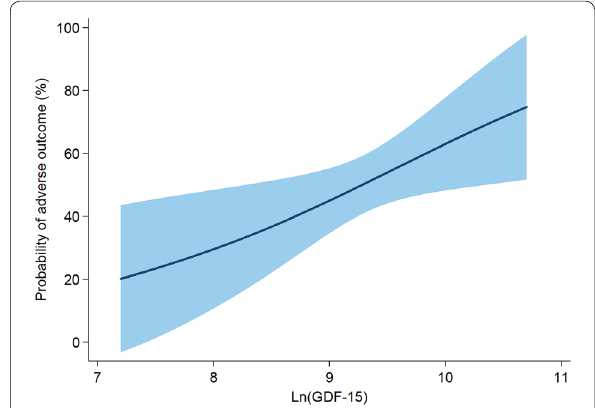
Fig. 2 Graph plot showing predictive margins (solid line), with 95% confidence intervals (shaded area), of adverse neurological outcome, according to GDF‑15 levels. GDF‑15 was transformed on a natural logarithmic scale